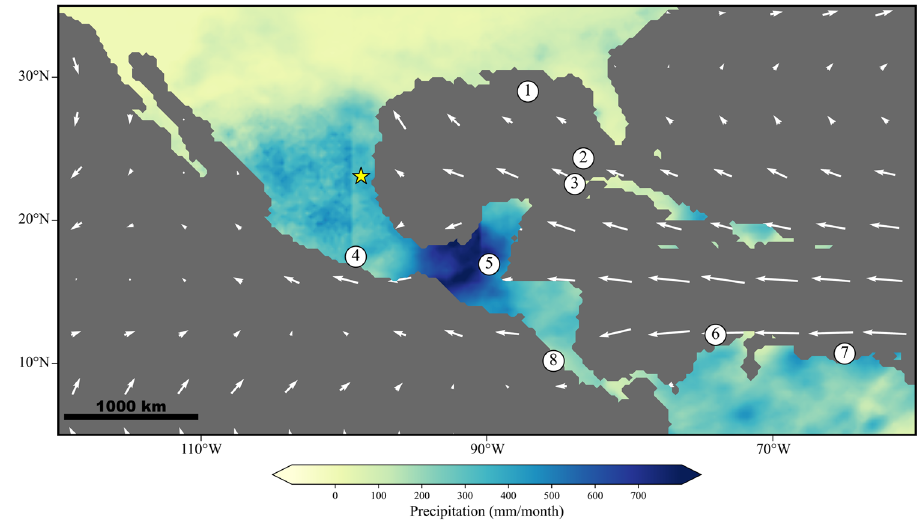
Fig. 1 | Summer (JJAS) climatology and nearby paleoclimate records. Map of regionalprecipitationand magnitude of low-level(850mb) windsusing PERSIANN precipitation data 106 and winds from MPI-ESM-Historical 107 .Nearby recordsinclude (1) anoceansediment corefrom the Gulf of Mexico 59 and the (2)FloridaStraight 49 ,